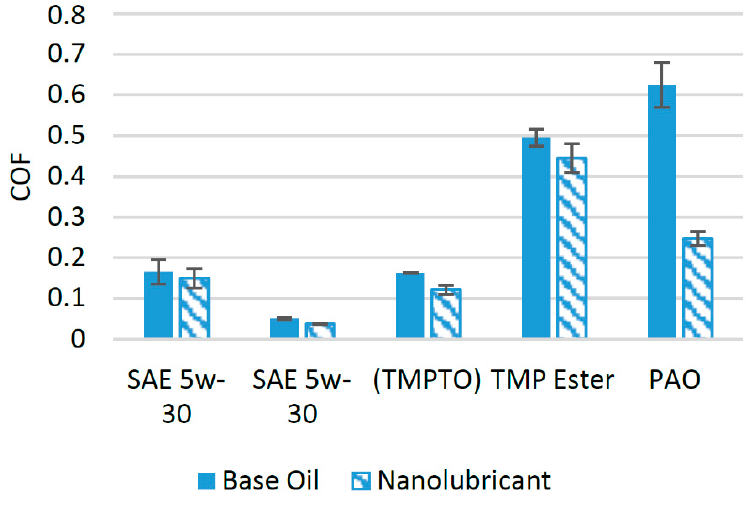
Figure 4. Effect of Gr NPs on the friction performance of synthetic lubricants.